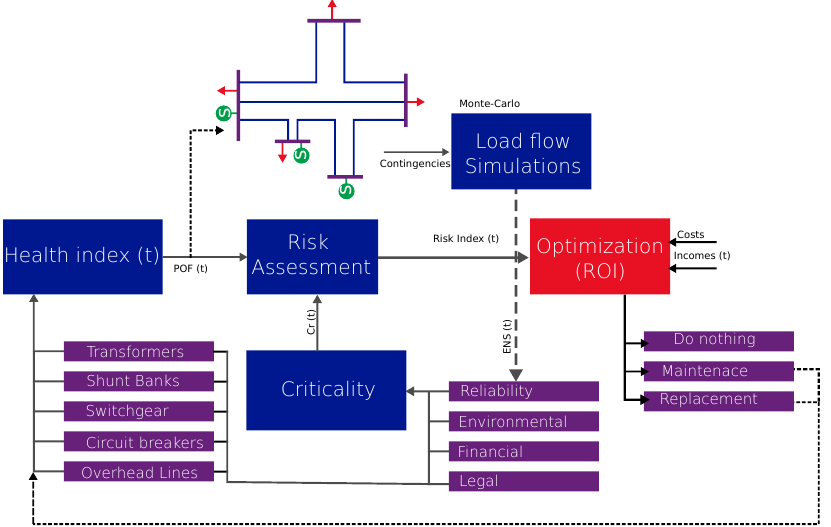
Figure 1. Proposed framework for optimal decision making of a power asset fleet using risk